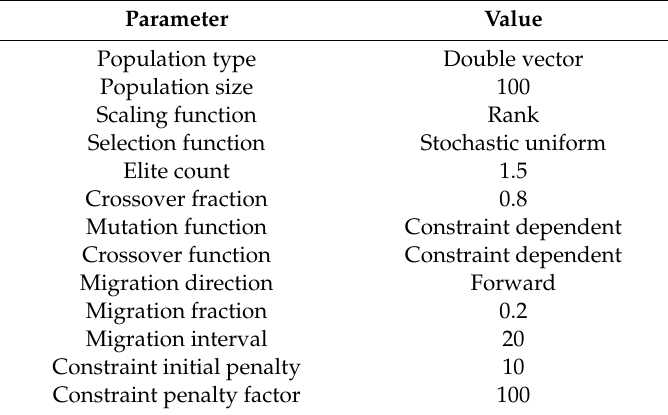
Table 4. Genetic algorithm parameters for the MATLAB optimization toolbox.